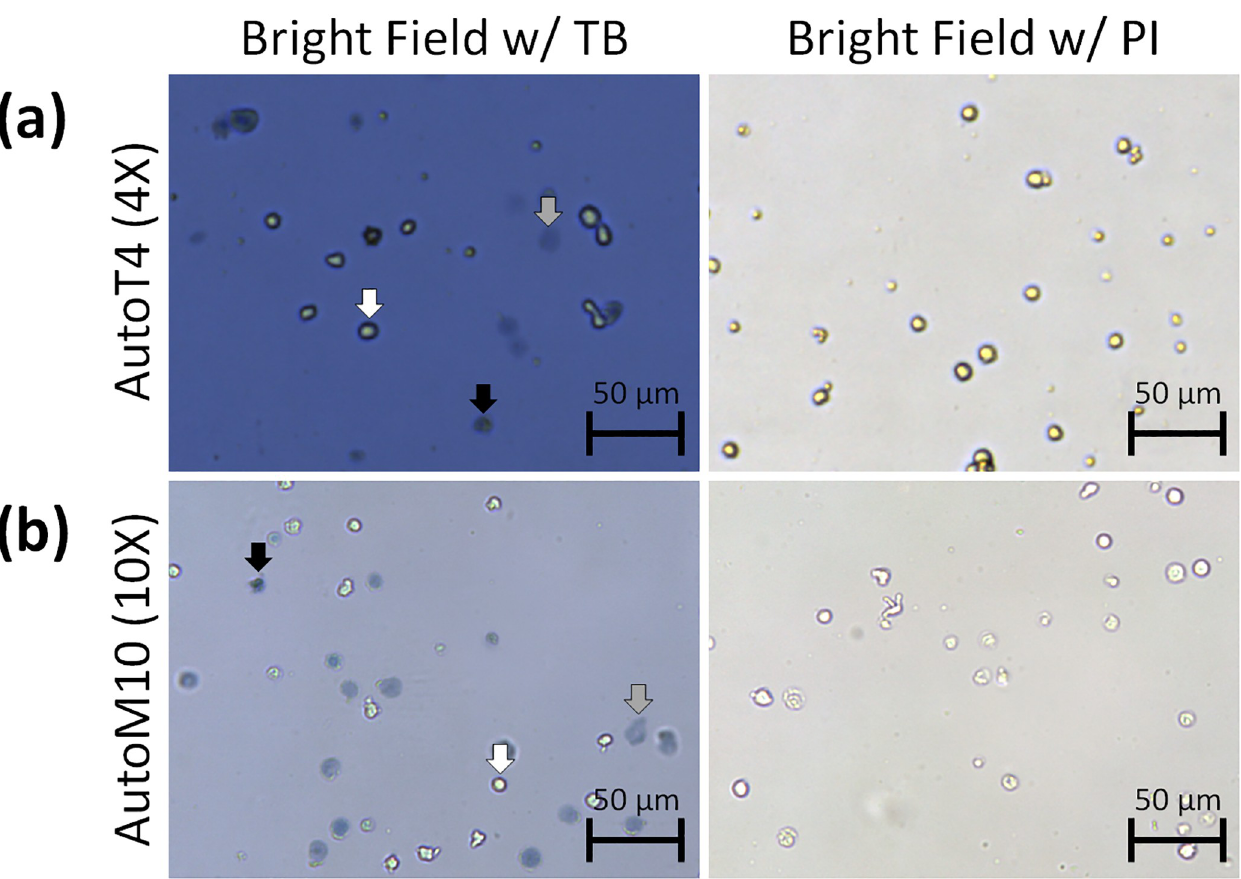
Fig 2. Bright field images of 2-day-old Jurkat cells stained with trypan blue or propidium iodide. The cells were imaged using the Cellometer AutoT4 (top) or AutoM10 (bottom). Trypan blue-stained Jurkat cells were classified into three groups: live (white arrow), dead (black arrow), and diffuse (gray arrow). The diffuse objects at 10X magnification showed bright materials surrounding them, resembling ruptured cell membrane. Cells stained with propidium iodide did not exhibit the same diffuse morphology as trypan blue-stained cells.